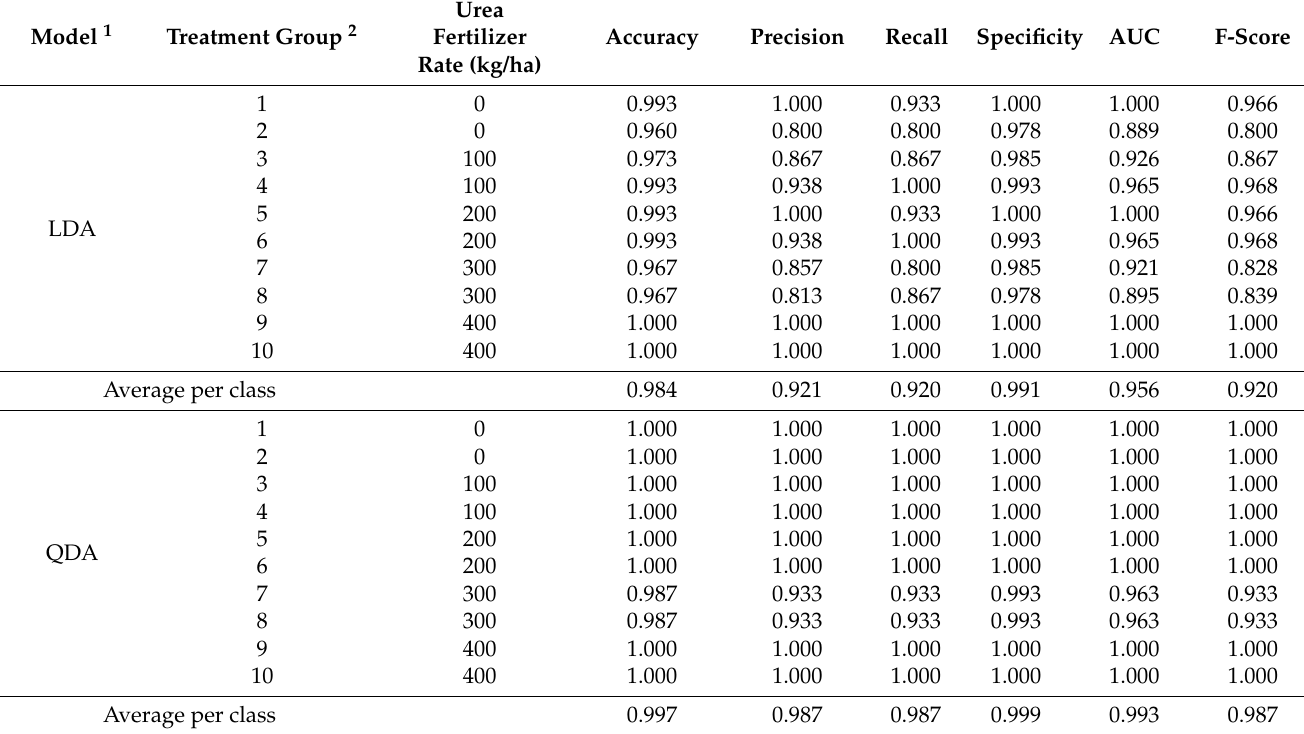
Table 3. Performance parameters of the LDA and QDA models for the ten-group